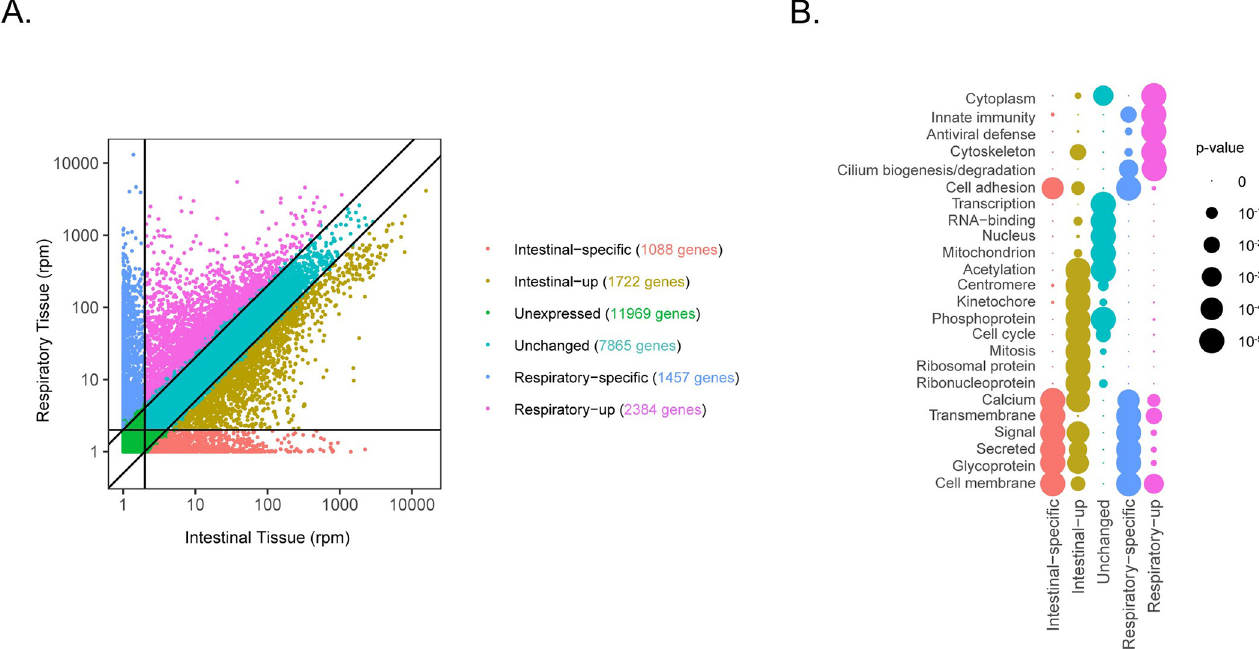
Fig 4. Comparison of the transcriptomic profile of non-infected respiratory and intestinal tissues. A) Gene expression in RNA reads per million (rpm) of mock-infected respiratory and intestinal tissues. A threshold of 1rpm determines expressed genes (horizontal/vertical lines). 2-fold changes determine “tissue- up” genes. Expressed genes were divided in 5 groups: orange (intestinal specific transcripts), brown (transcripts highly expressed in intestinal tissues), turquoise (transcripts equally expressed in both tissues), pink (transcripts highly expressed in respiratory tissues), blue (respiratory specific transcripts). Unexpressed genes in both tissues (‹1 rpm) are represented in green. B) Functions associated to each group of genes in A). Functions were defined by the top enriched uniport keywords associated to each group of genes. Circle sizes represent p-value . The list of genes for all categories is provided in the GEO database with accession number